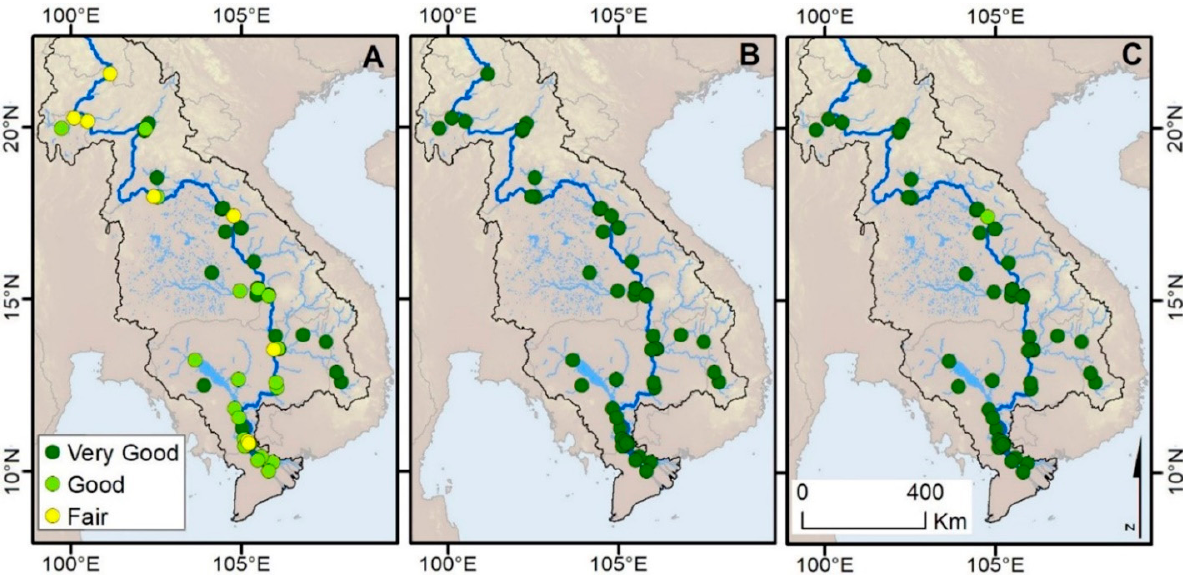
Figure 2. Biotic water quality classification at each sampling site during the 2000s, based on BMWP-Thai ( A ), ASPT-Thai ( B ), and Lincoln ( C ) indices.